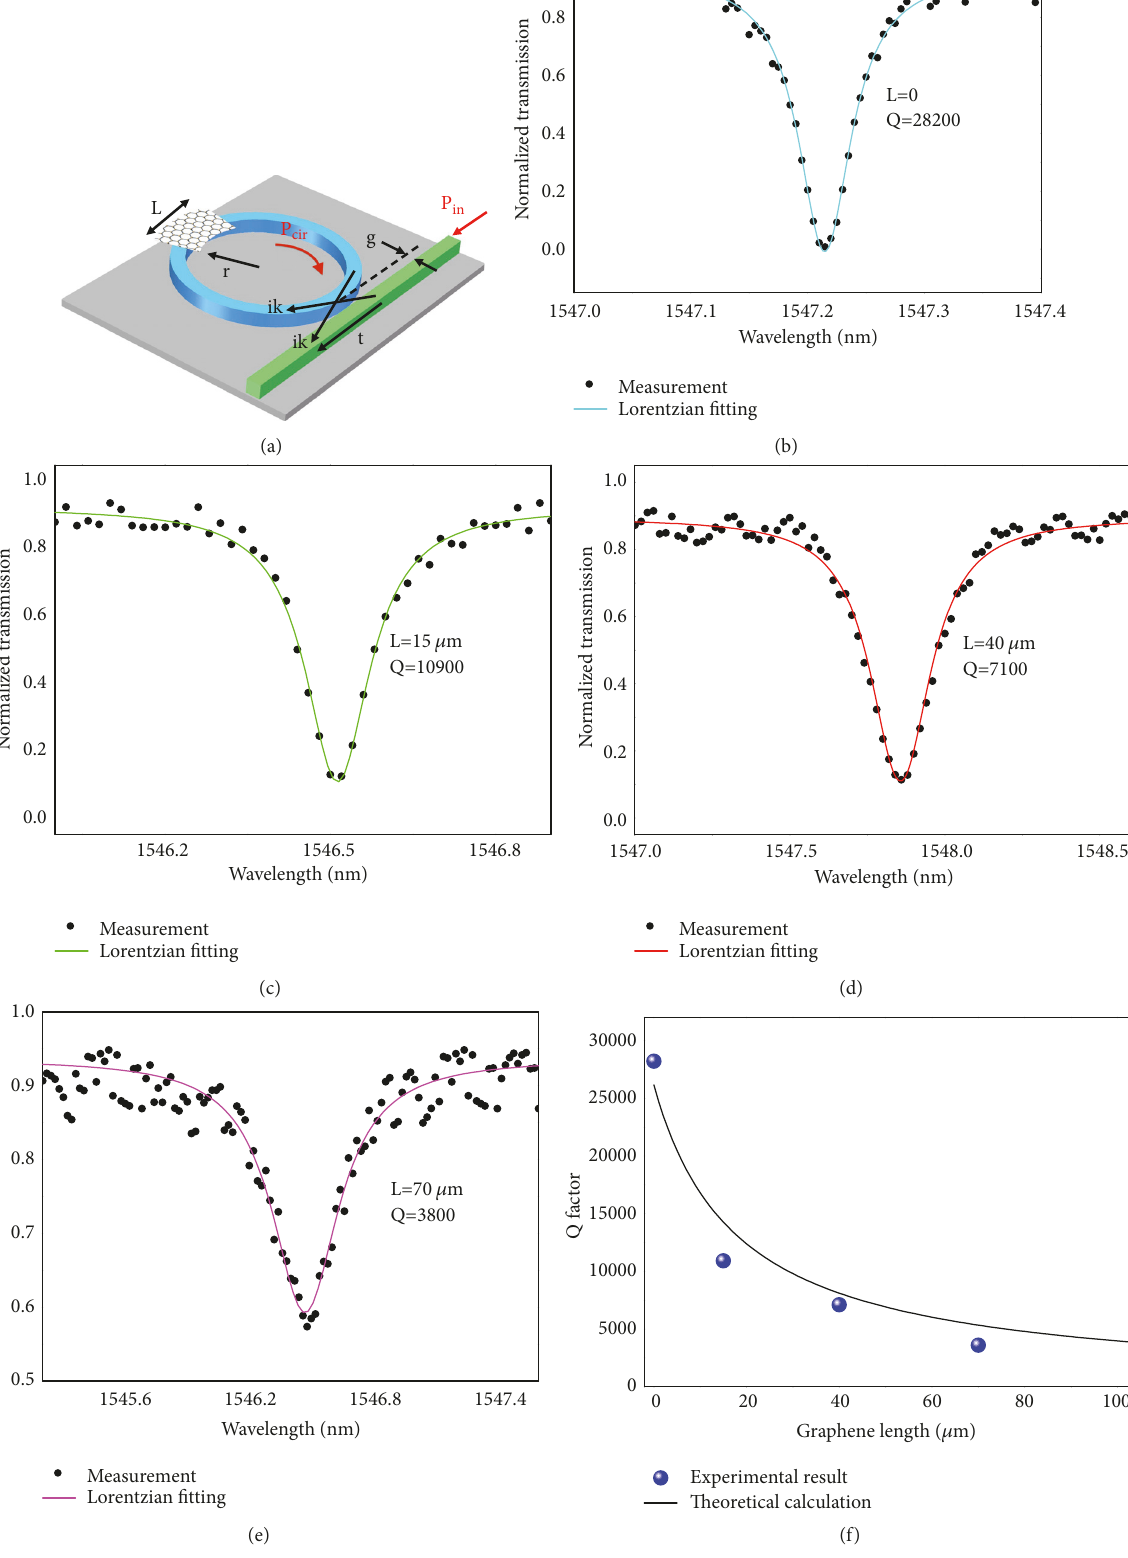
Figure 2: Graphene-on-silicon nitride microring resonators. (a) Schematic of the graphene-on-silicon nitride microring resonator. (b)–(e) Experimental measurements of resonance spectra of the graphene-on-silicon nitride microring resonators with graphene lengths of 0 𝜇 m, 15 𝜇 m, 40 𝜇 m, and 70 𝜇 m. (f) Experimental and theoretical results of the 𝑄 factor as a function of graphene length. Figure 2 is reprinted